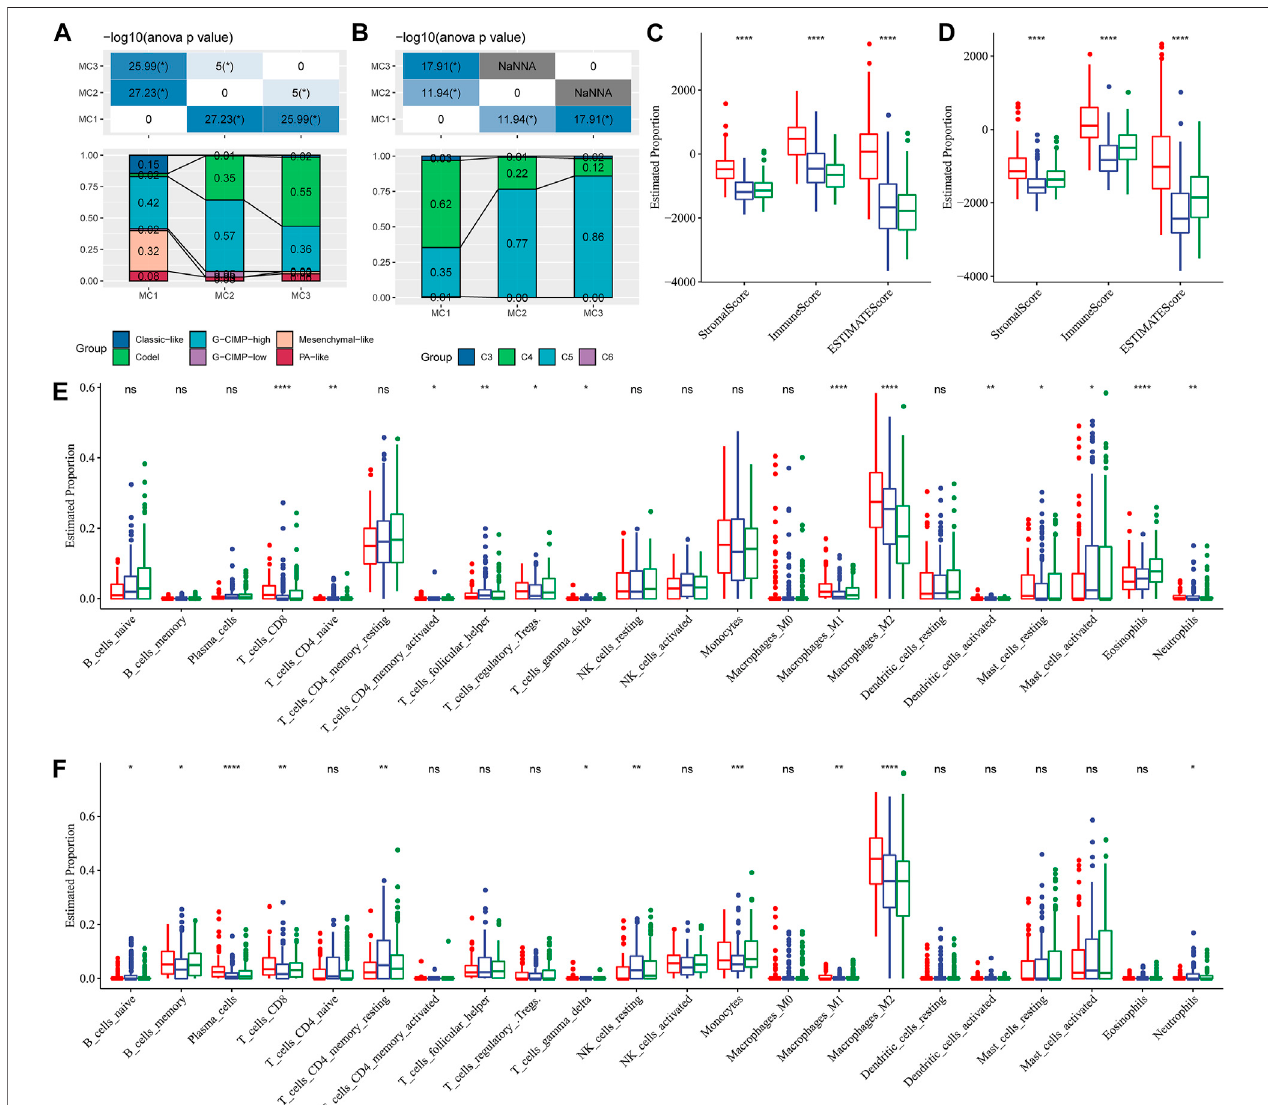
FIGURE 3 | Comparison of differences in classical immune cell typing and immune cell composition analysis. (A) Comparative analysis of the metabolic molecular subtypes in TCGA and the reported six classical subtypes. (B) Comparative analysis of the metabolic molecular subtypes in TCGA and the previous six pan-cancer immunemolecularsubtypes. (C) ImmunecellcompositionandproportionintheTCGAcohortgivenbyESTIMATEsoftware. (D) Immunecellcompositionandproportion intheCGGAcohortgivenbyESTIMATEsoftware. (E) ImmunecellcompositionandproportionintheTCGAcohortgivenbyCIBERSORTsoftware. (F) Immunecell composition and proportion in the CGGA cohort given by CIBERSORT software.